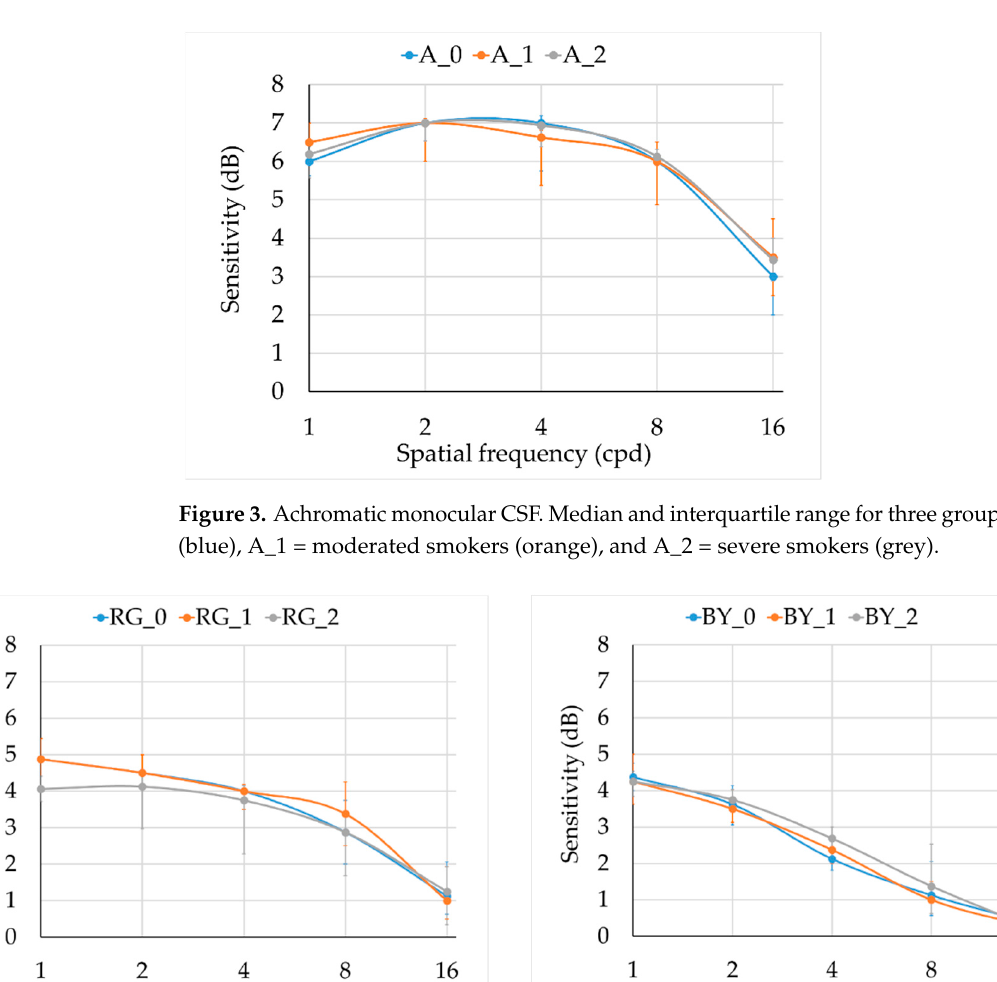
Figure 3. Achromatic monocular CSF. Median and interquartile range for three groups: A_0 = controls (blue), A_1 = moderated smokers (orange), and A_2 = severe smokers (grey). Table 2. Statistic results for the achromatic (A) and chromatic (RG and BY) contrast sensitivity comparison among groups at each frequency.